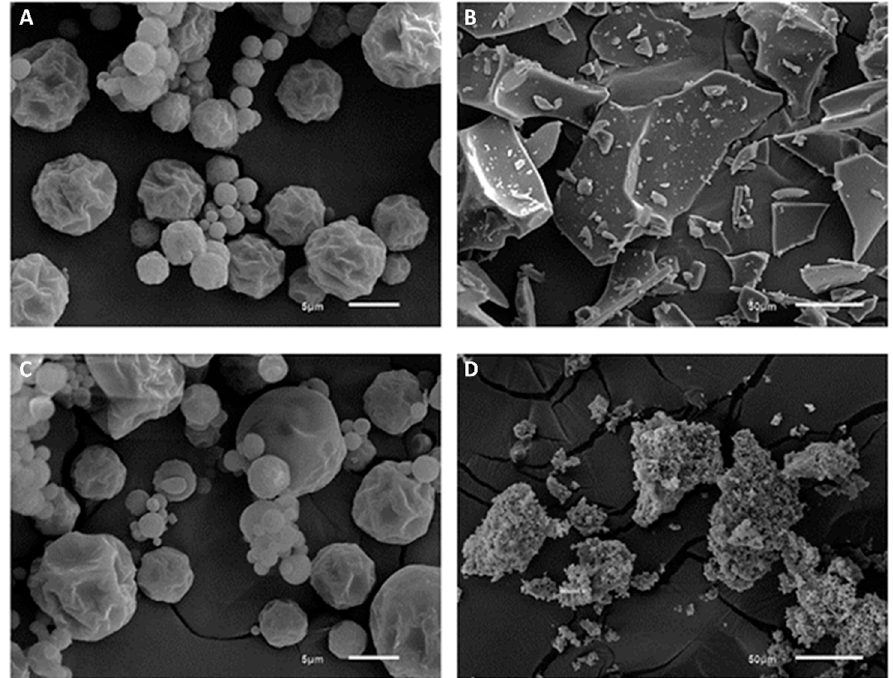
Figure 1. Micrographs of encapsulated green coffee extracts. ( A ) spray dryer with polydextrose; ( B ) spray dryer with inulin; ( C ) freeze-drying with polydextrose; ( D ) freeze-drying with inulin. ( A , B ) 3000 × magnification; ( C , D ) 400 × magnification.